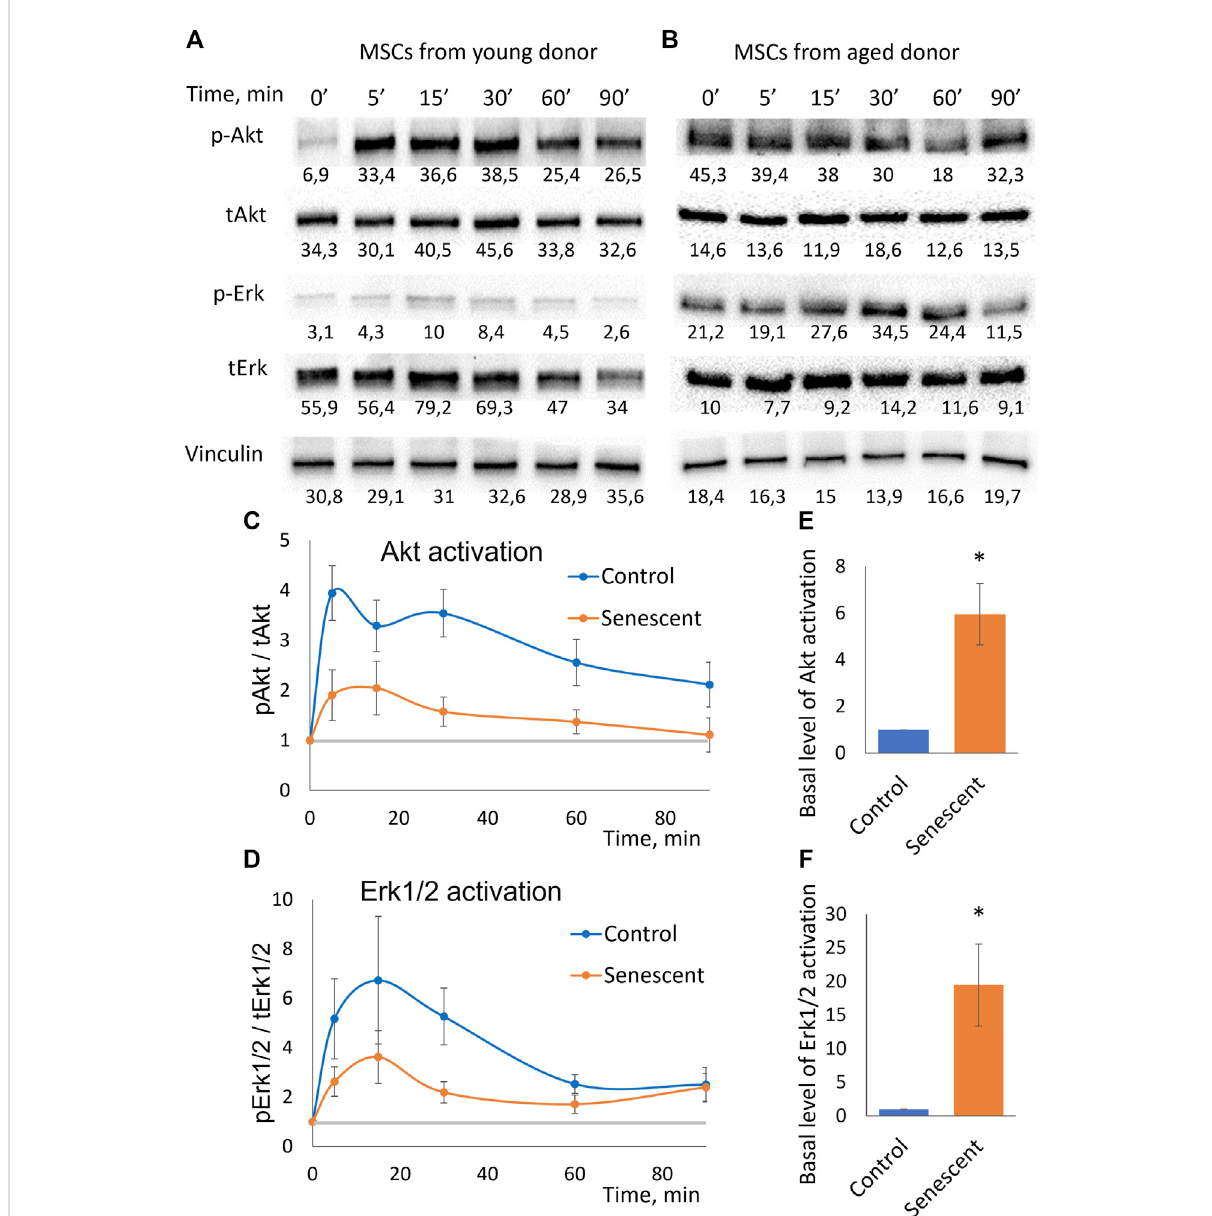
FIGURE 3 Insulin-dependent signaling in control and senescent MSCs. (A,B) . Representative results of Western-blot analysis of Akt (Thr308) and Erk1/ 2 phosphorylation under the action of insulin in different time points in control (A) and senescent (B) MSCs. The results of densitometric analysis marked under the protein bands; (C) . Time dynamics of Akt (Thr308) phosphorylation in control and senescent MSCs under insulin stimulation, n = 6 Y-axis represent ratio in Western-blot band volume between p-Akt (T308) and total Akt; (D) . Time dynamics of Erk1/2 (Thr202/Tyr204) phosphorylationincontrolandsenescentcellsunderinsulinstimulation, n =6Y-axisrepresentratioinWestern-blotbandvolumebetweenp-Erk1/2 (Thr202/Tyr204)andtotalErk; (E,F) .BasallevelofAkt (E) andErk1/2 (F) phosphorylationincontrolandsenescentcells, n =4 – 5.Mean±SE,* p <